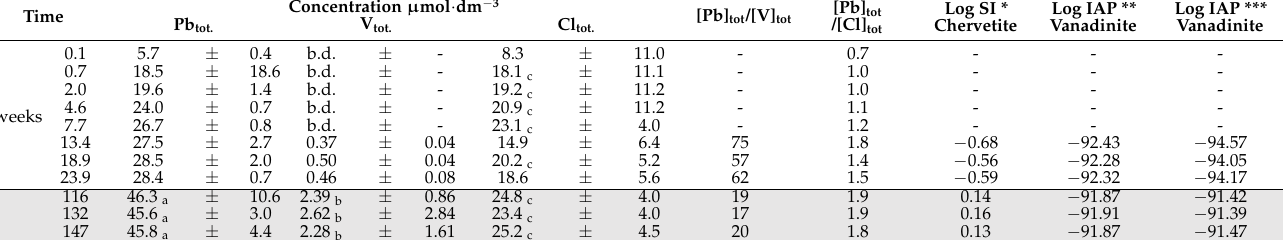
Table 1. Selected parameters of experimental solutions: the raw and calculated